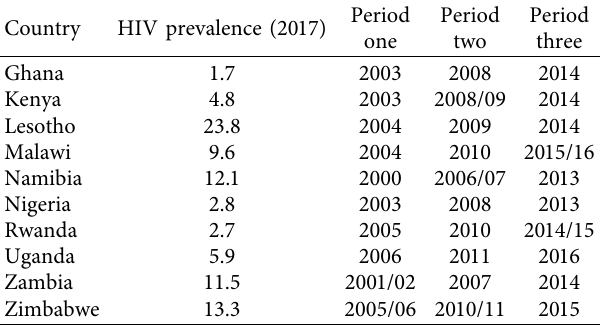
Table 1: Selected countries and their 3 most recent survey years. Country HIV prevalence (2017)